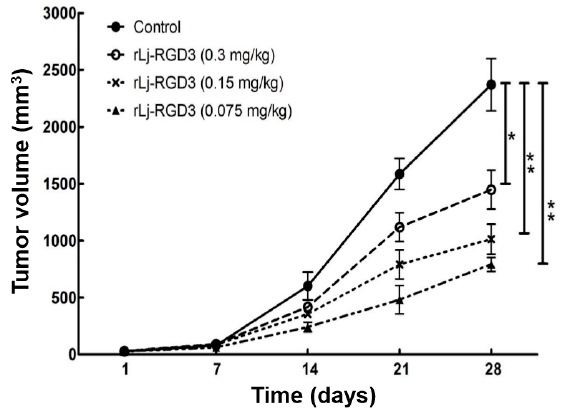
Figure 2. rLj-RGD3 inhibited the growth of the tumors in HeyA8 xenografted mice ( n = 8). Relative to the control group: * p < 0.05; ** p < 0.01.